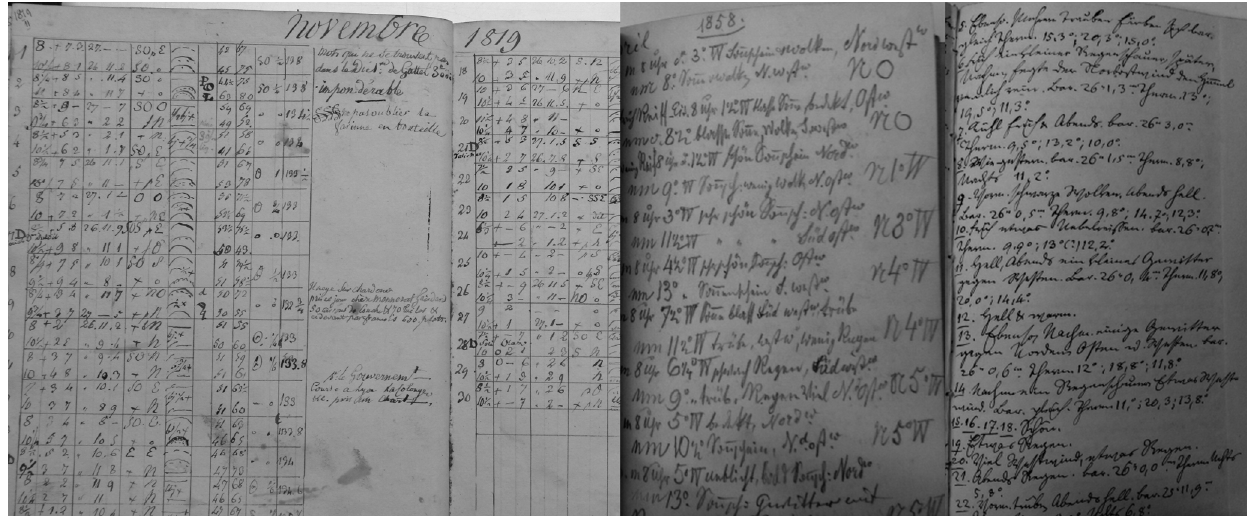
Figure 1. Two examples of data sheets from Vevey and Schaffhausen from the Swiss Federal Archives (signatures: E3180-01#2005/90#202 ∗ ; E3180-01#2005/90#231 ∗